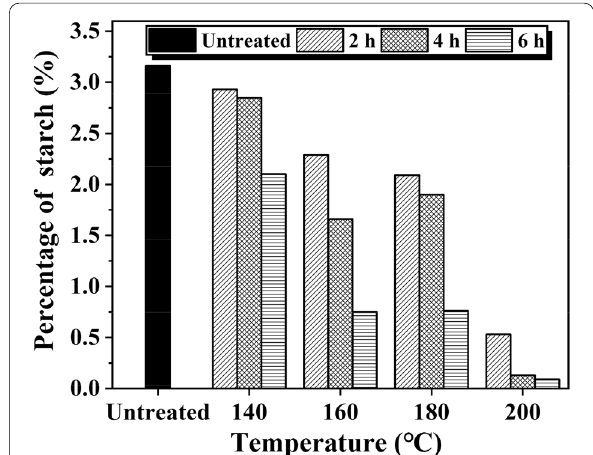
Fig. 11 The starch content of untreated and oil heat-treated samples at varied temperature (140, 160, 180 and 200 °C) for varied time (2, 4 and 6